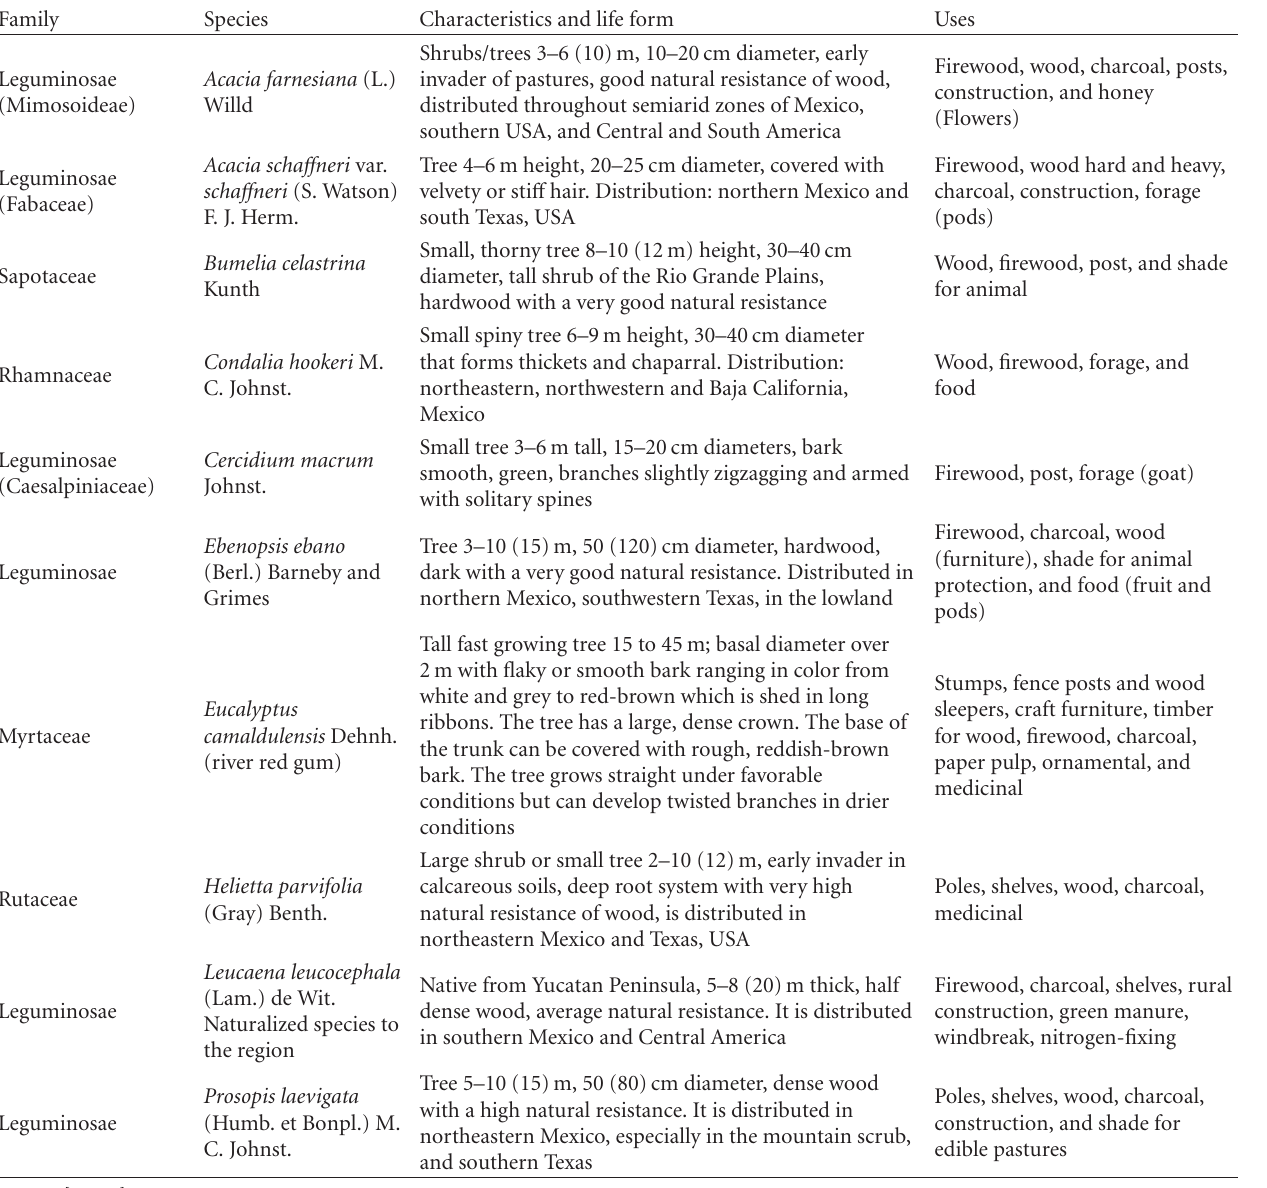
Table 1: Outstanding characteristics of the 10 woody plant species selected for